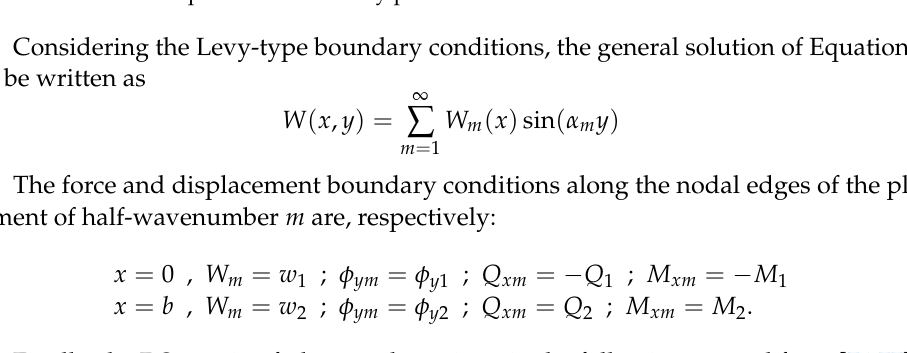
Figure 2. Force and displacement of a Levy plate